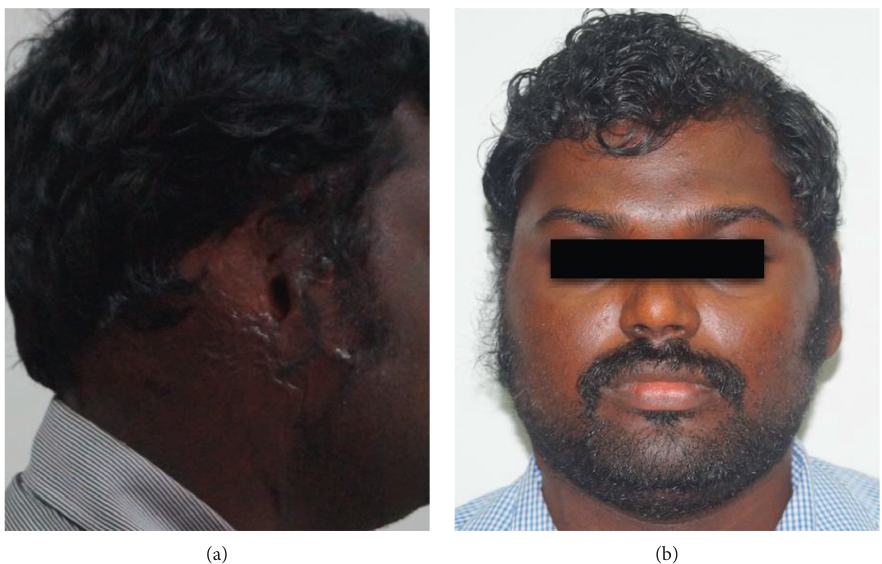
Figure 1: Profile and frontal photographs of patient missing ear.